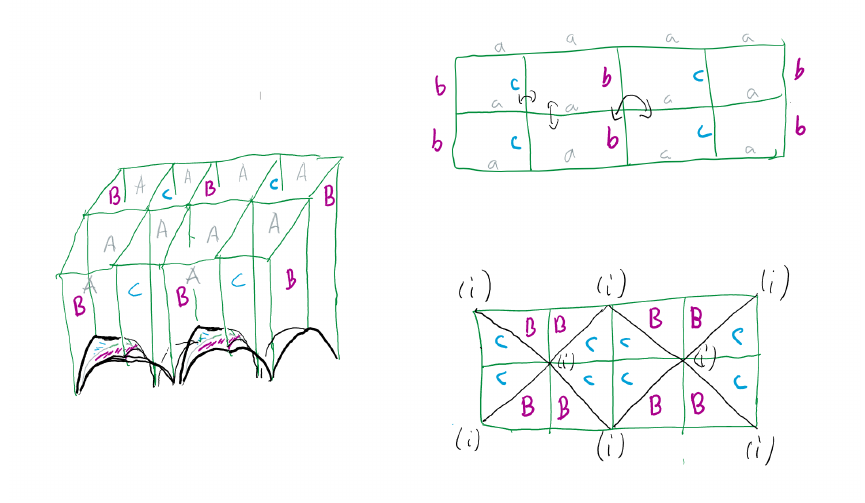
Figure 10: The polygon P contains 6 facets drawn in the upper half space. Four are 3 vertical walls (A.2) and two are patches of hemispheres (A.3). On the right we have shown the projection of the bottom of the figure to z = 0. The vertices labelled by “i" are ideal vertices, building blocks for cusps. A minimal color scheme is included following the rules in [ 25 ] , with no adjacent sides having the same color.